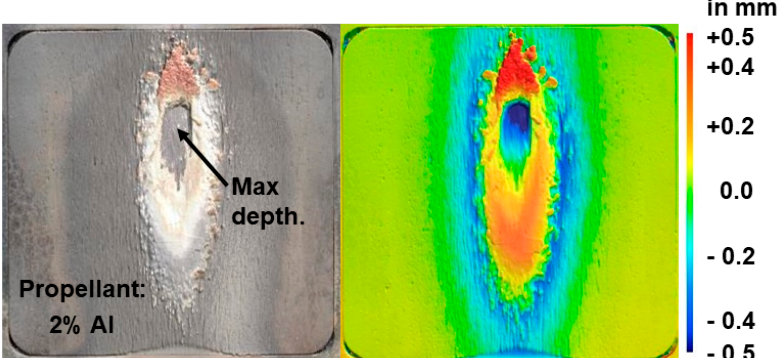
Figure 5. Surface of a sample after VMK testing using the 2% Al propellant; ( left ) optical view, ( right ) colour-coded contour map of the same image.